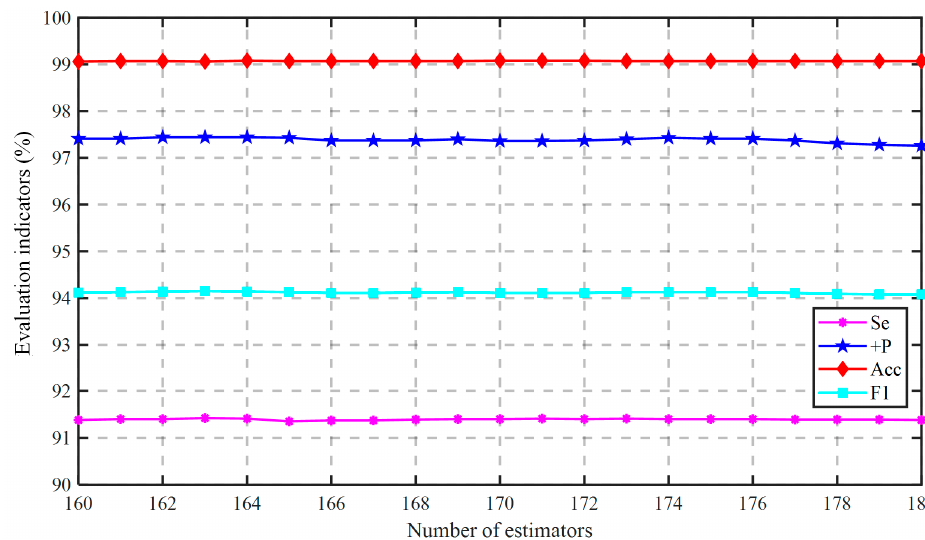
Figure A2. The fine-grained tuning of the “n_estimators”.